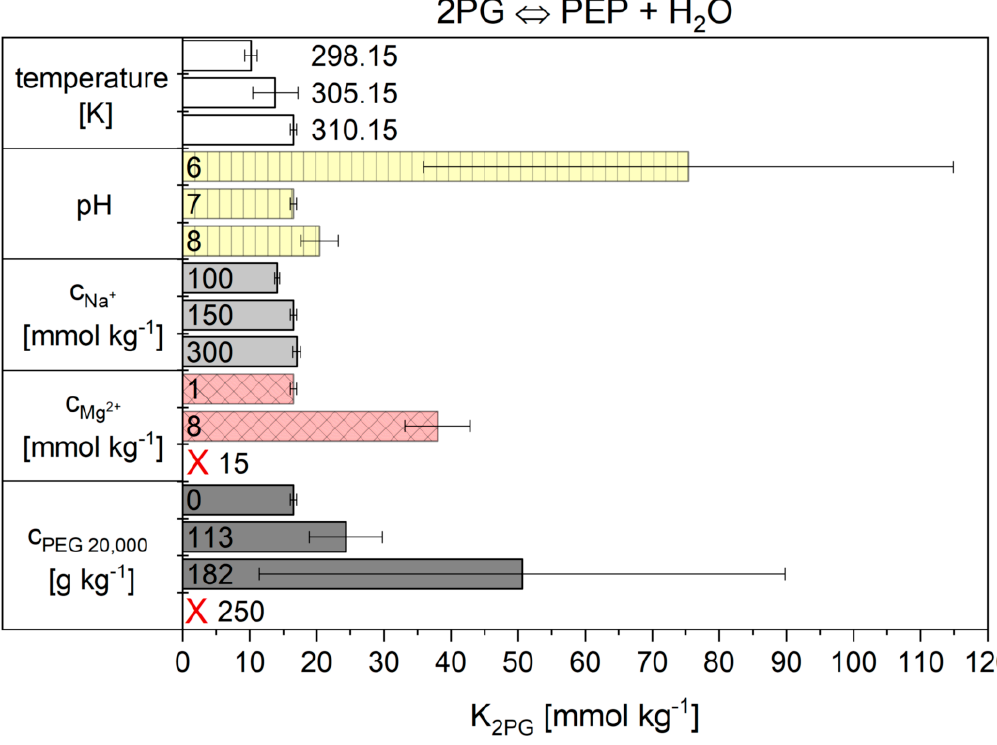
Figure 6. K 2PG values obtained for reaction 9 from the Noor model. The error bar results from the standard deviation of the triple determination of each measurement condition. The red crosses mark the two conditions where no significant fit parameters were